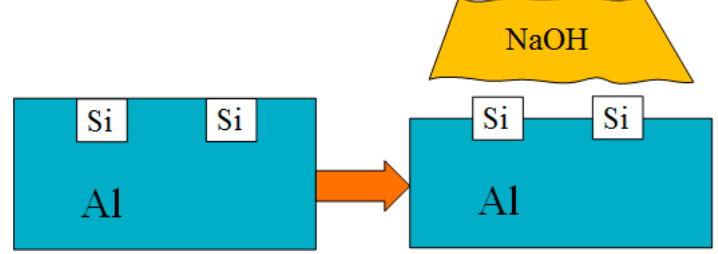
Figure 3. Chemical etching process of the Al–Si alloy cylinder liner.